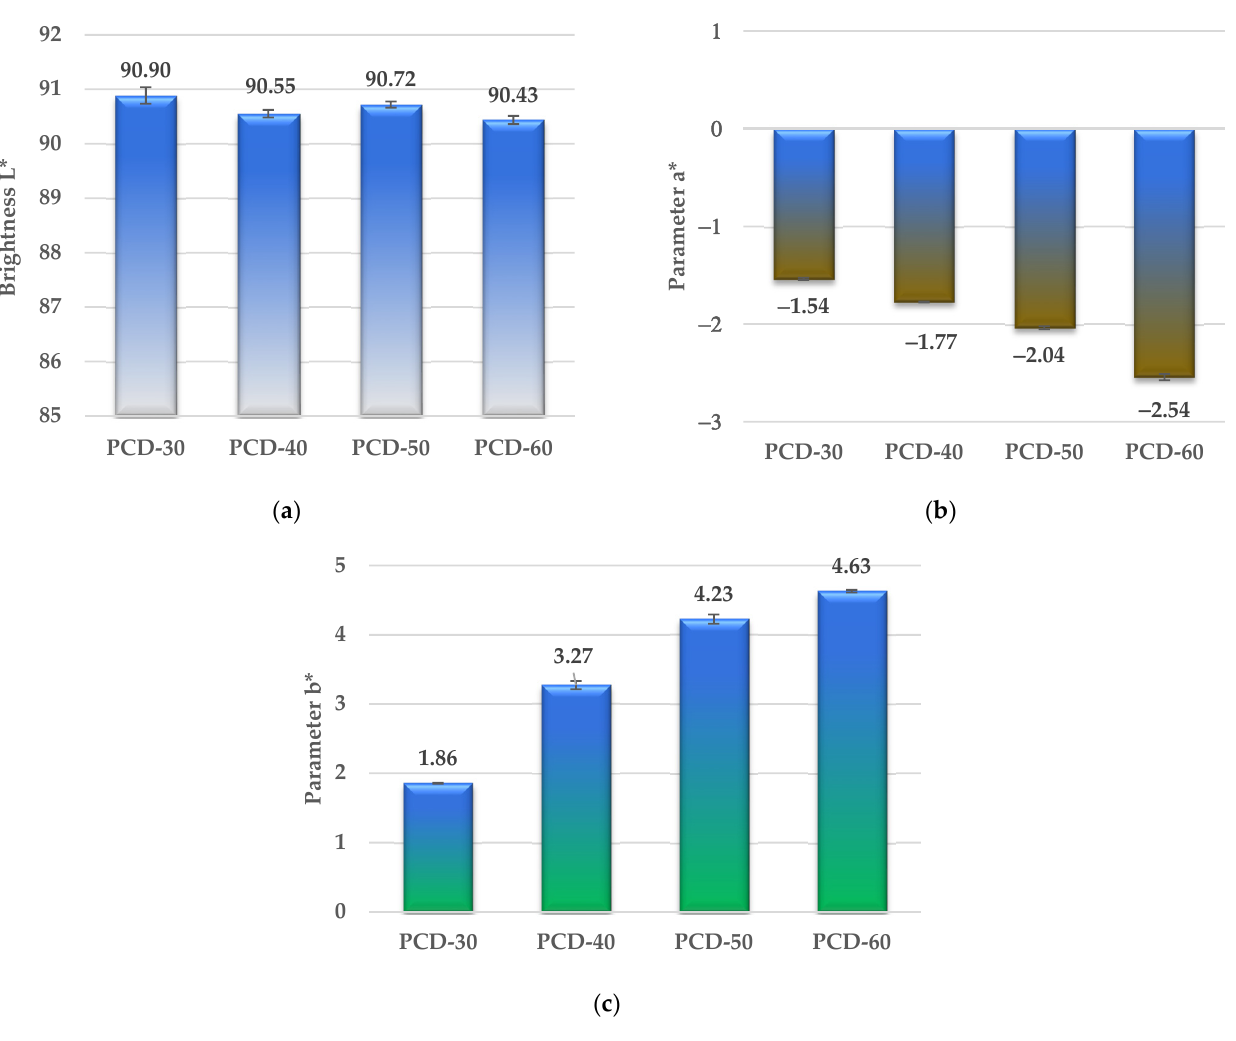
Figure 9. Brightness L* ( a ), parameter a* ( b ) and parameter b* ( c ) of synthesized PTURs.